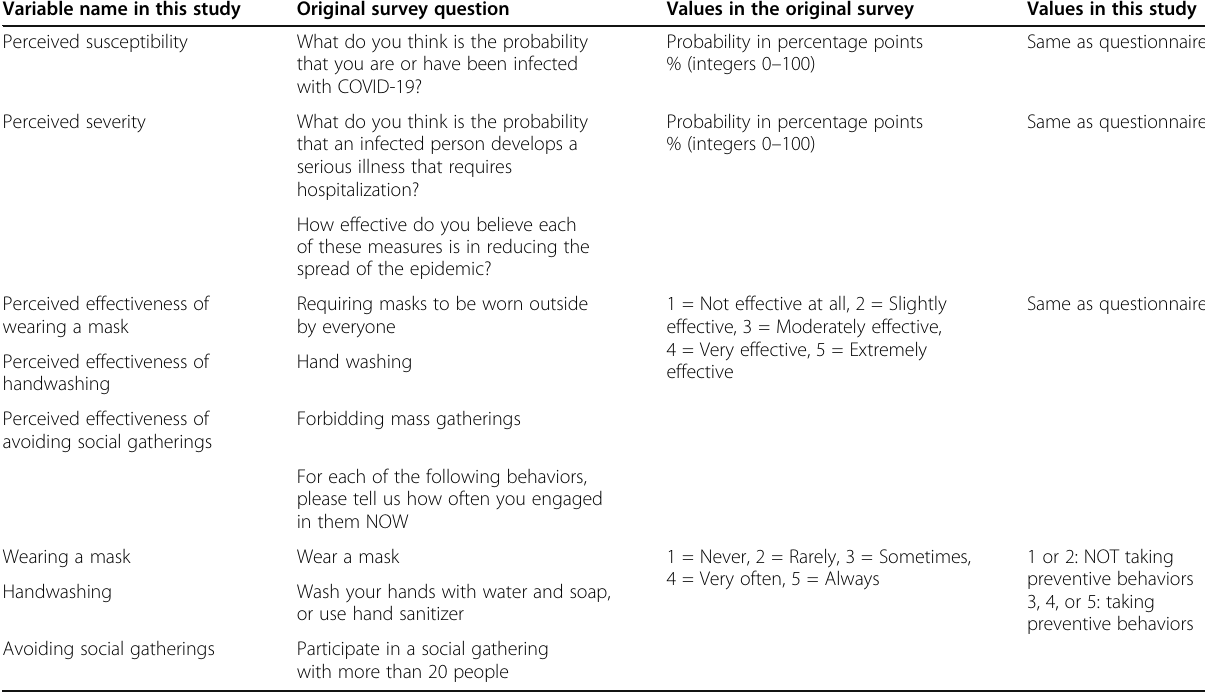
Table 1 List of variables for public perception and preventive behaviors in this study (compared with the questions and values in) and the original